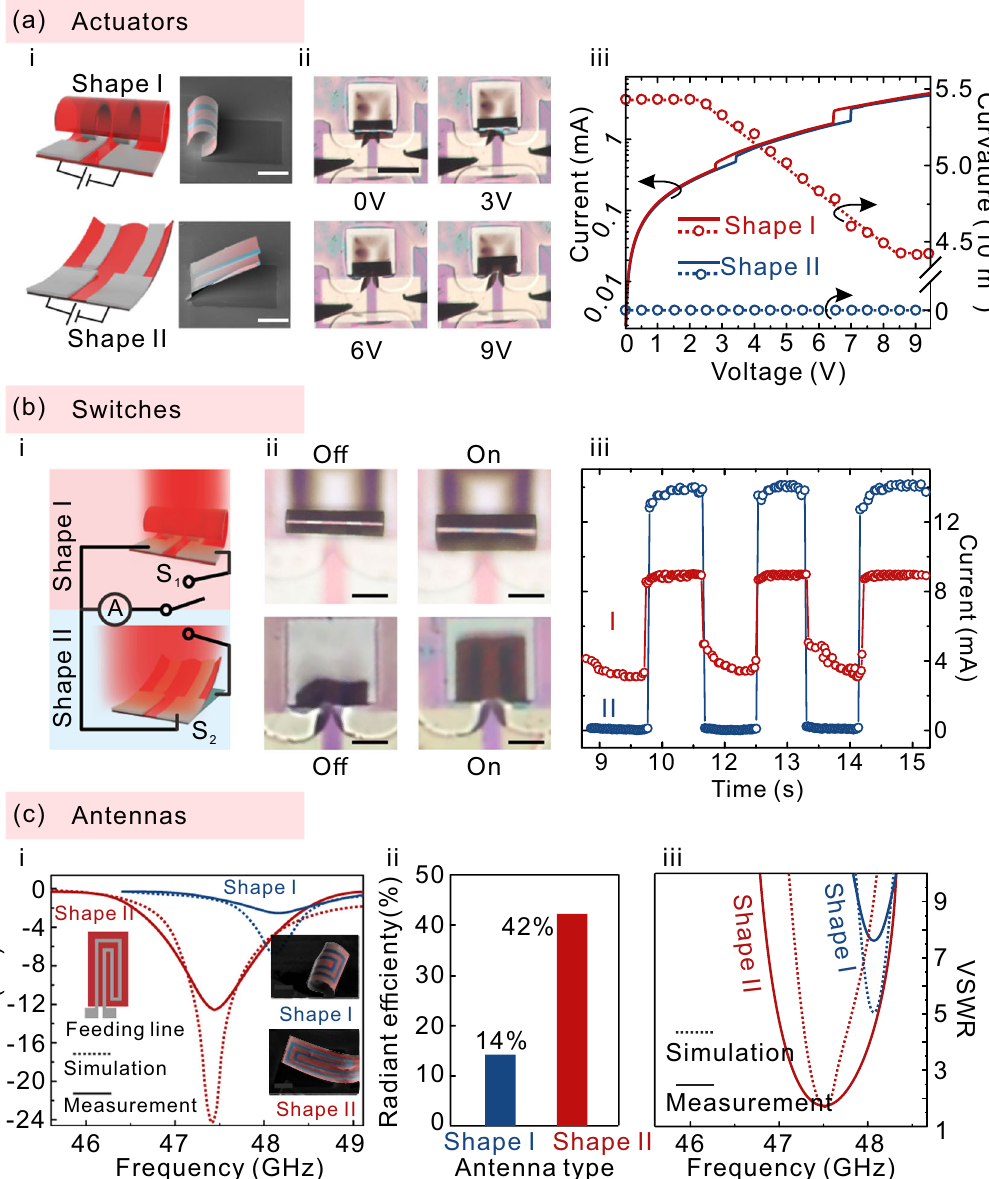
Fig. 5 Dual-functional architecture devices. a MEMS microactuators controlled by electric signals. (i) Schematics and SEM images of microactuators. The scale bar is 40 μ m. (ii) Optical images of actuating behavior of shape I actuator with various voltages. The scale bar is 100 μ m. (iii) Current – voltage characteristics (solid line) and corresponding curvature (dashed line) change of two shapes. Empty circles present experimental curvature. b MEMS switches. (i) Schematic of morphable MEMS switches. The shape I and II serve as a different type of switches (S 1 and S 2 ), which can turn into the other with extra stimuli. (ii) Optical images of the switches in shape I (upper) and II (lower) without (off) and with laser irradiation (on). The scale bar is 30 μ m. (iii) Current change with laser irradiation as the on-off of the switch. The red and blue lines represent the switch in shape I and II, respectively. c Concealable antennas. (i) Measured (solid line) and simulated (dashed line) return loss (S11) versus frequency for the shape I and II, respectively. Left inset is the scheme of 2D precursor. Top-right and bottom-right insets show the SEM images of antennas in shape I and II, respectively. The scale bar is 100 μ m. (ii) Simulated radiant ef fi ciencies of the antenna type. (iii) Measured and simulated VSWR versus frequency response for two